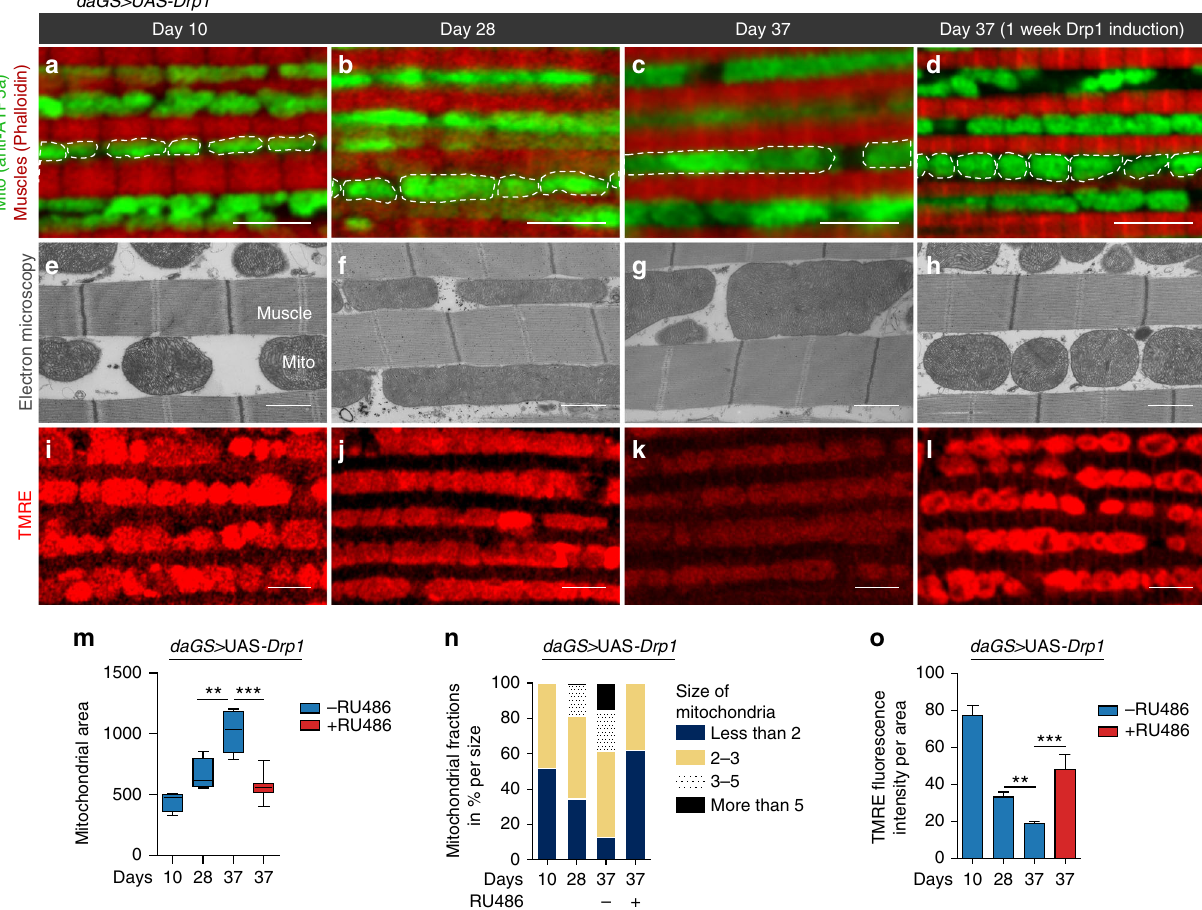
Fig. 3 Midlife Drp1 induction rejuvenates mitochondrial morphology and function. a – d Immunostaining of indirect fl ight muscles from day 10, 28 and 37 daGS > UAS-Drp1 females with or without RU486-mediated transgene induction from day 30 to day 37 showing mitochondria ( green channel , anti-ATP5a) and muscles ( red channel , rhodamine staining for F-actin). Scale bar is 5 µ m. e – h Electron micrograph of indirect fl ight muscles from day 10, 28 and 37 daGS > UAS-Drp1 females with or without RU486-mediated transgene induction from day 30 to day 37, showing mitochondria and muscles. Scale bar is 1 µ m. i – l Staining of indirect fl ight muscles from day 10, 28, and 37 daGS > UAS-Drp1 females with or without RU486-mediated transgene induction from day 30 to day 37 showing TMRE fl uorescence. Scale bar is 5 µ m. m Quanti fi cation of mitochondrial size in indirect fl ight muscles from day 10, 28, and 37 daGS > UAS-Drp1 females with or without RU486-mediated transgene induction from day 30 to day 37 as shown in a – d . n = 4 – 7 fl ies; *** p < 0.001, ** p < 0.01; one-way ANOVA/Bonferroni ’ s multiple comparisons test. n Quanti fi cation of relative mitochondrial size in indirect fl ight muscles from day 10, 28, and 37 daGS > UAS-Drp1 females with or without RU486-mediated transgene induction from day 30 to day 37 as shown in e – h . Data are represented as mitochondrial fractions in percentages per size. n = 3 fl ies per condition. o Quanti fi cation of mitochondrial membrane potential measured by TMRE